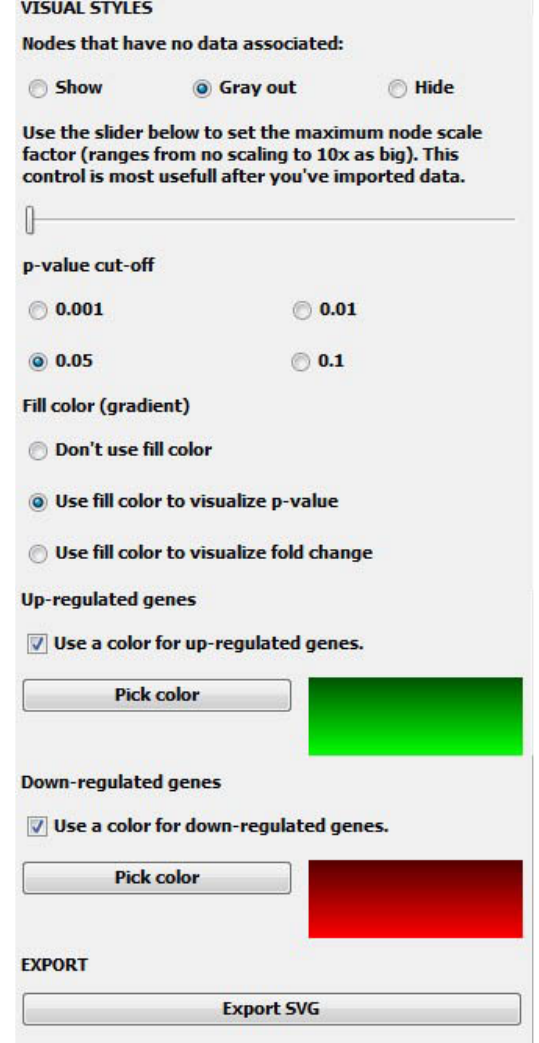
Figure 2. Configuring the visual styles. The user can customize several visualization settings by changing the Visual styles. Nodes that have no data associated can be shown (default), greyed out or hidden. For hidden nodes, the associated edges will also be hidden. The node color can be set to reflect the p-value cut-off (0.001, 0.01, 0.05 and 0.1) or fold change. The default colors are green (HEX #00FF00) for “up-regulated genes” and red (HEX #FF0000) for “down-regulated genes”. The user can choose different colors by pressing the Pick color buttons. After customization, the user can export the visualization to an SVG image